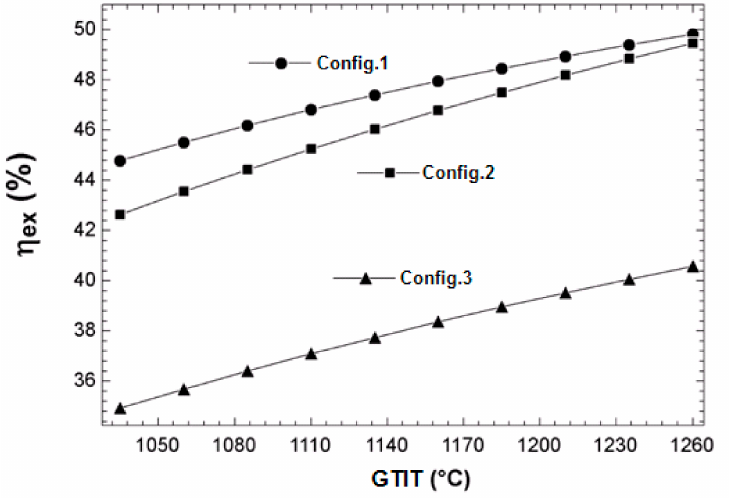
Figure 10. Effect of gas turbine inlet temperature change on the overall exergy